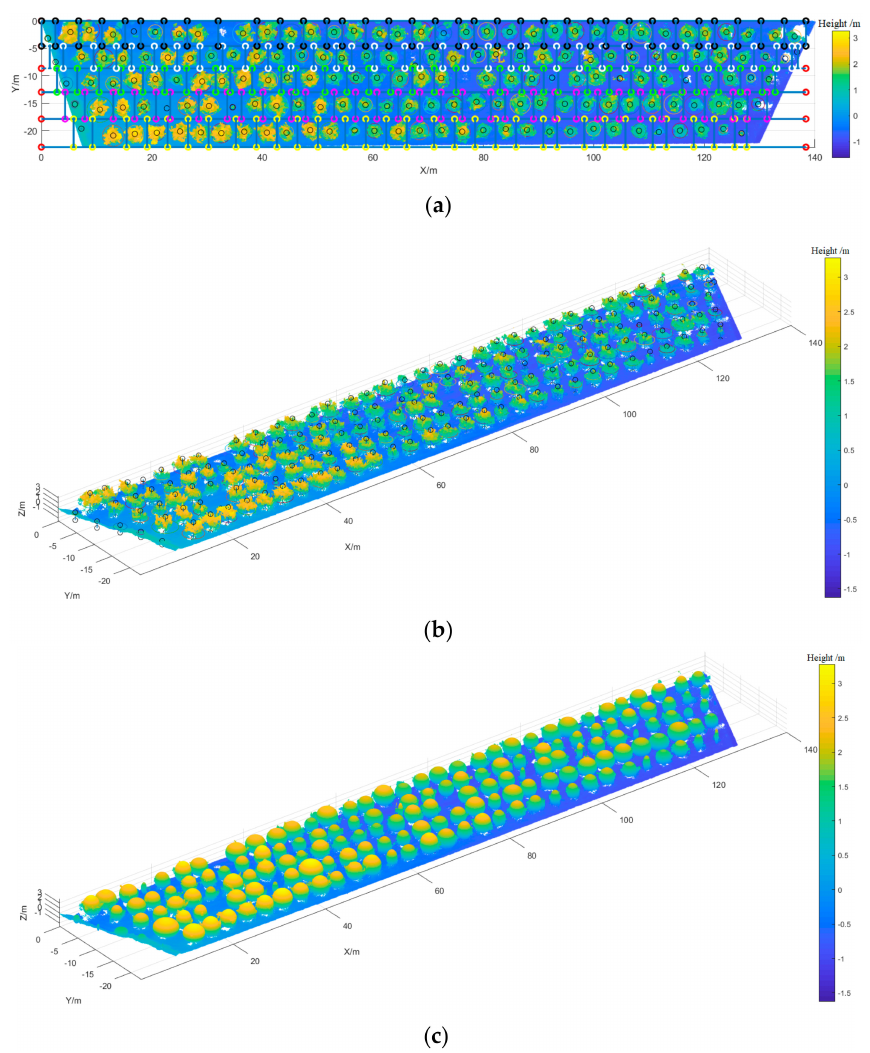
Figure 7. Orchard canopy detection. ( a ) Circumscribed equivalent circles of the orchard canopy projectionsontheXOYplane; ( b )Orchardcanopyheightdetection; ( c )Orchardcanopyvolumedetection.